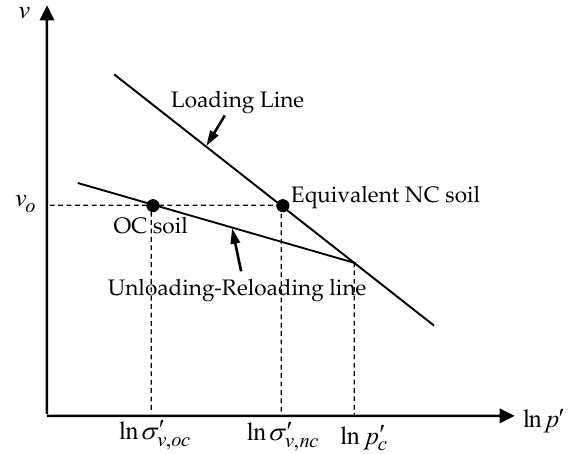
Figure 4. Relationship between equivalent NC and OC soils.